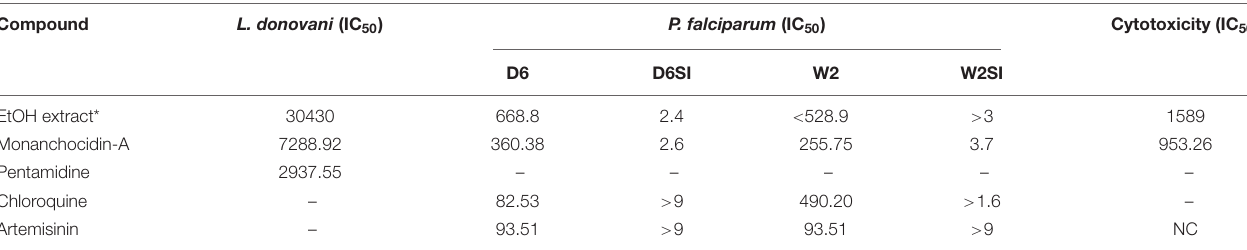
TABLE 5 | Antiprotozoal activity of monanchocidin A in µ